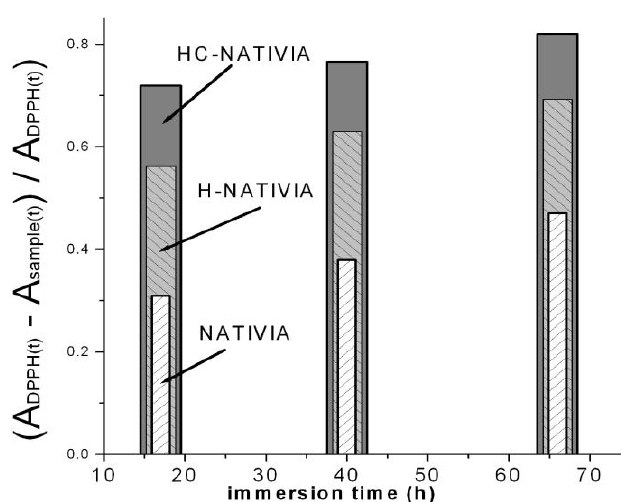
Figure 7. Antioxidant activity versus immersion time for the NATIVIA ® films coated with Chit-H–clove oil (HC-NATIVIA), Chit-H (H-NATIVIA), and the uncoated film (NATIVIA).